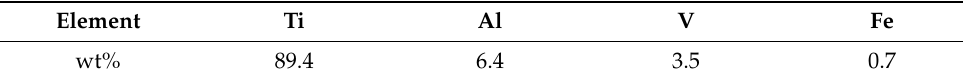
Table 1. Chemical composition of grade 5 titanium wire.